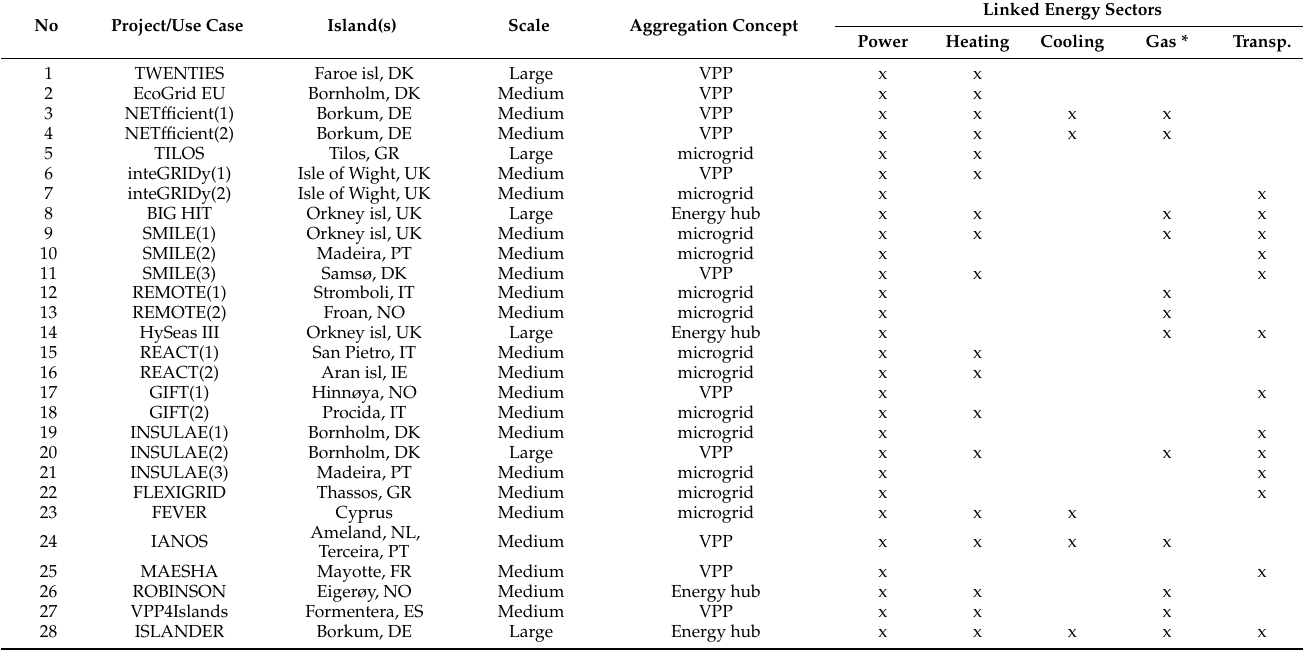
Table 1. Characterization of demonstration use cases under investigation. Scale: medium–from 100 kW to 1 MW, large–over 1